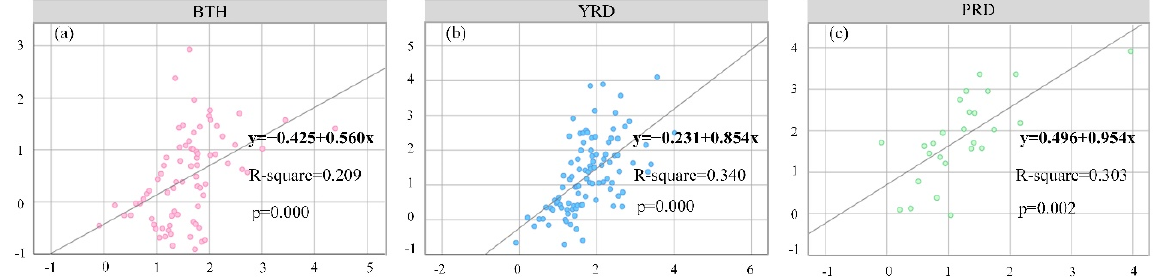
Figure 6. Relationship between the relative heat island intensity (RHII) (°C) and log 10 Sc (built-up area (km 2 )). ( a ): BTH, Beijing–Tianjin–Hebei; ( b ): YRD, Yangtze River Delta; ( c ): PRD, Pearl River Delta.